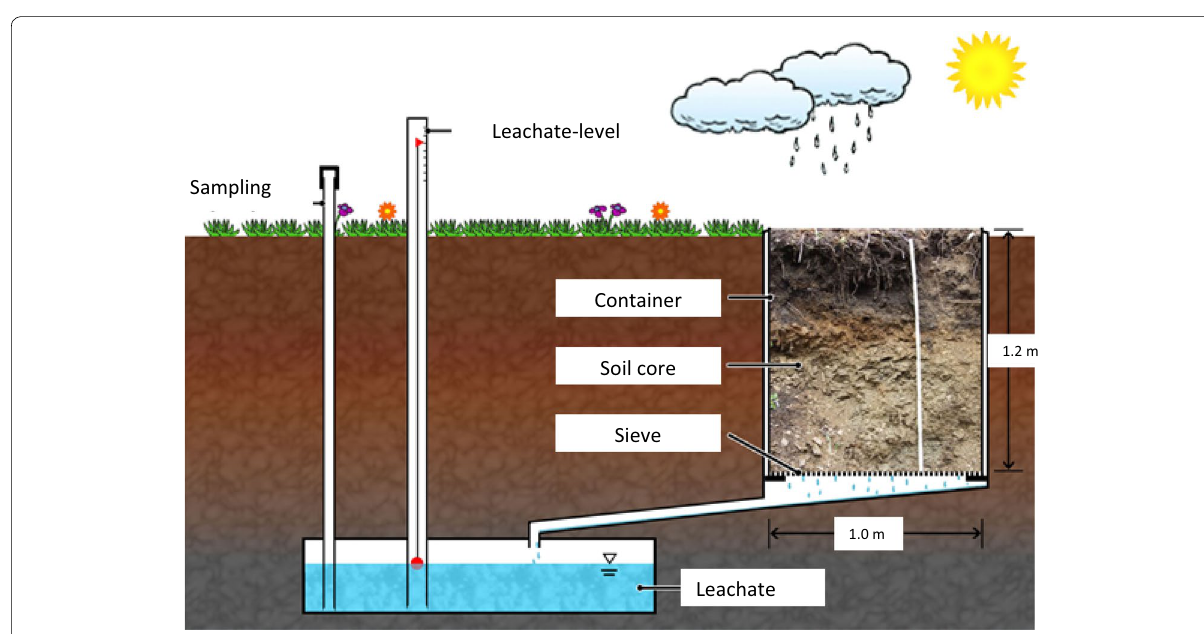
Fig. 4 Scheme of outdoor